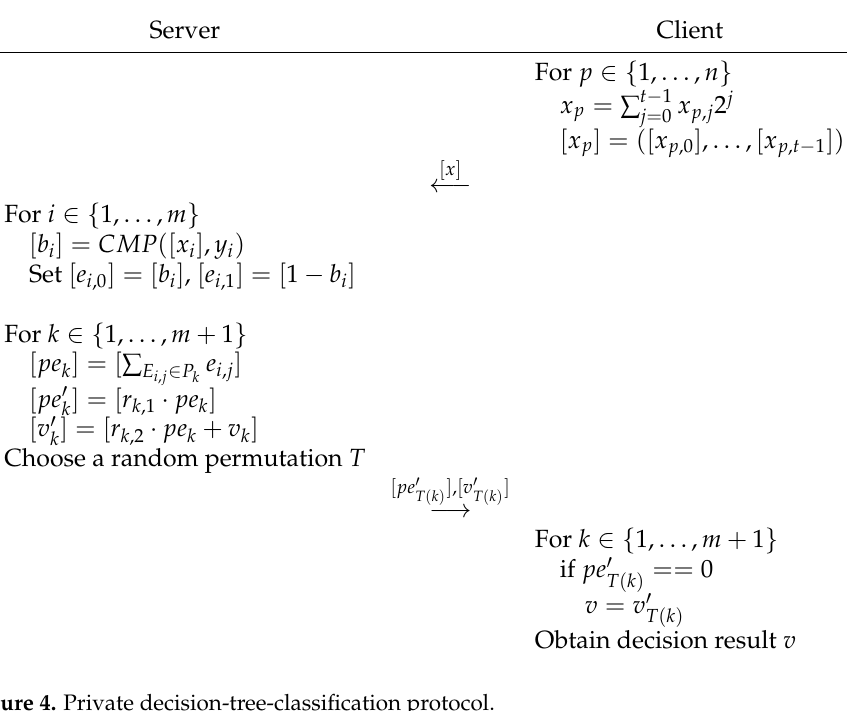
Figure 4. Private decision-tree-classification